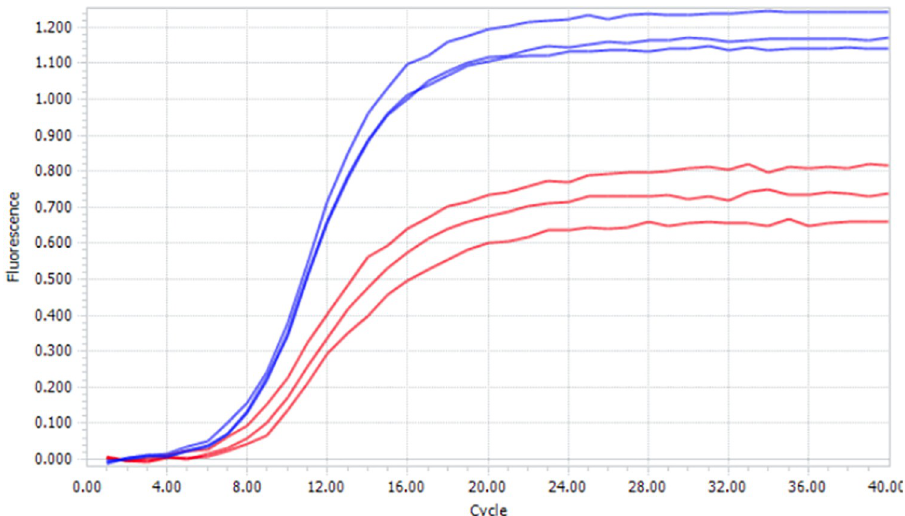
Fig 12. Real time PCR showing emergence of fluorescence from intercalated Evagreen 1 without emulsification (blue lines) and in the emulsified PCR (red lines). The aqueous phase was emulsified by mixing 100 μ L of aqueous phase mixed with 300 μ L of fluorinated oil (1 volume of LMW fraction and 4 volumes of the HMW fraction, see protocol 1) with 2% of surfactant (a-R 2 ). Assays done by triplicate.